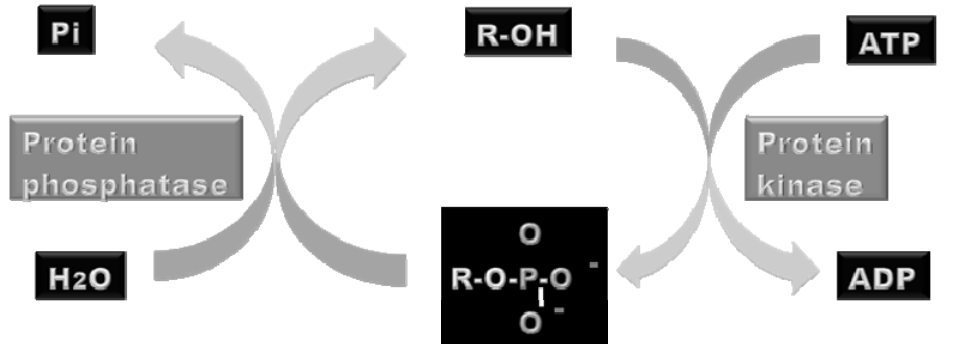
Figure 1. Illustration of the catalytical activities of protein kinases and phosphatases. Protein kinases catalyses the addition of a phosphoryl group to a target protein using adenosine triphosphate (ATP) or guanosine triphosphate (GTP) as phosphate donors. On the other hand, protein phosphatases catalyze the hydrolysis of the phosphopeptide bond. Orthophosphate (Pi) is produced by